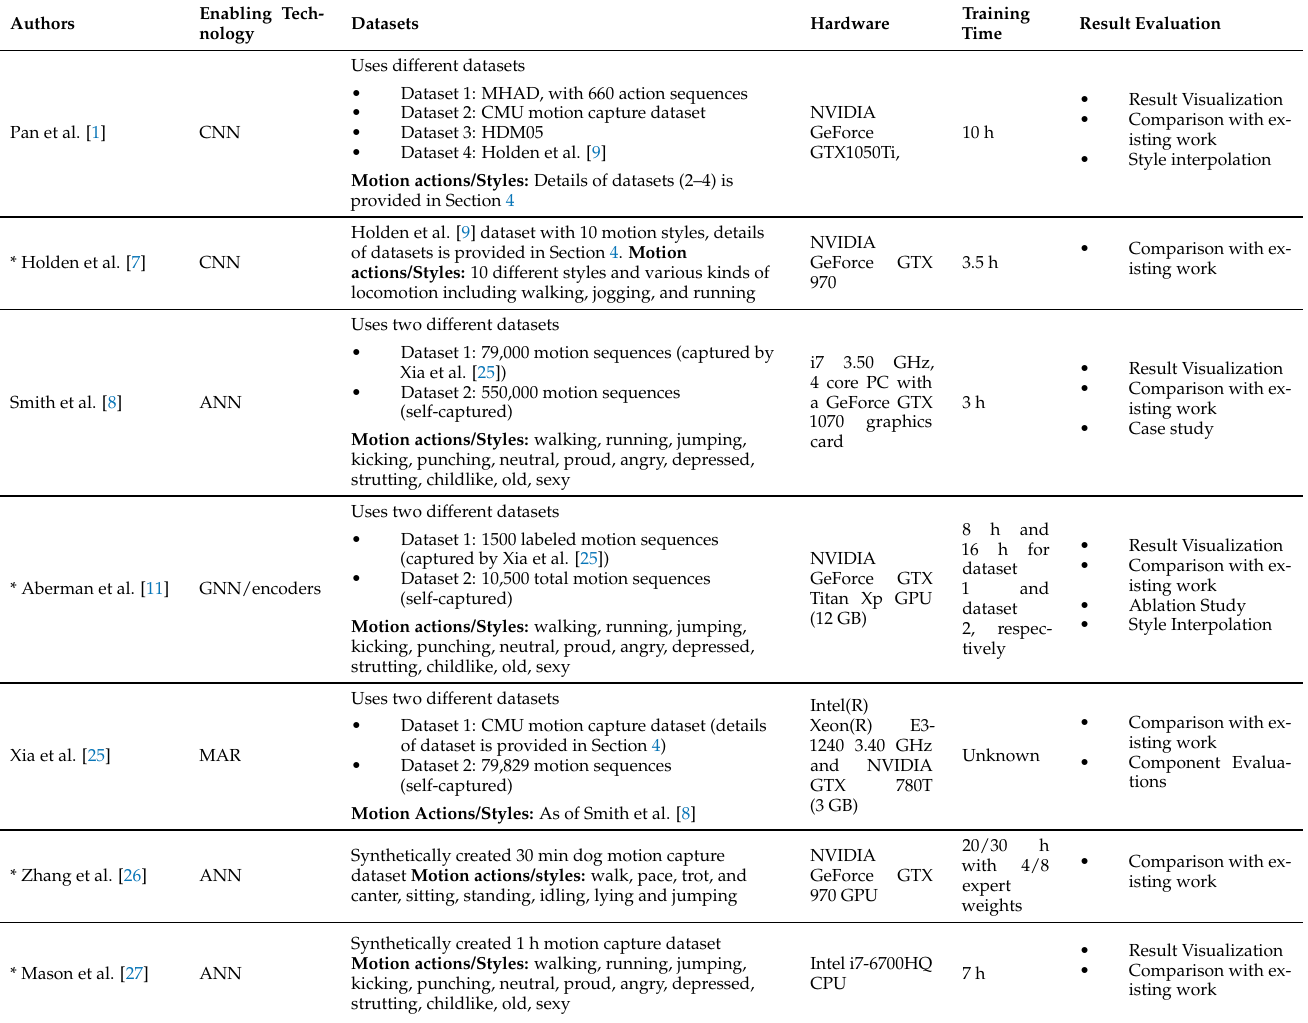
Table 1. Implementation details of motion style transfer